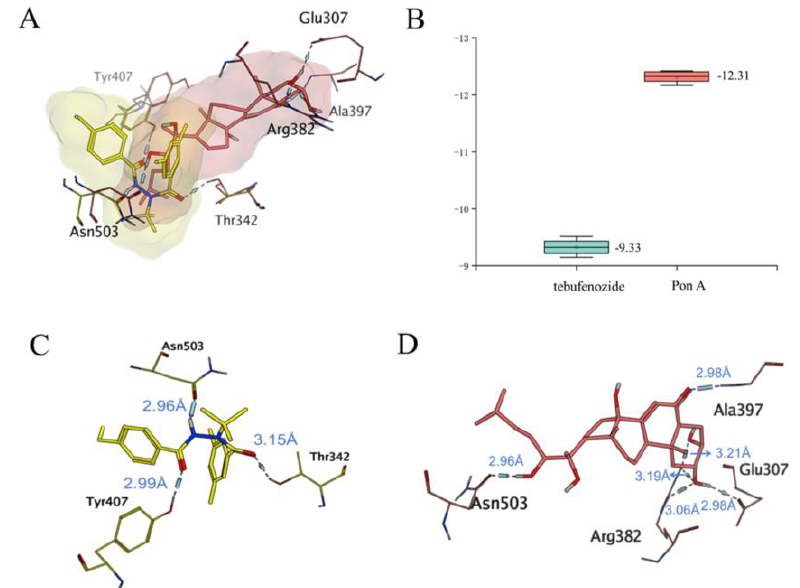
Figure 4. ( A ) Overlay diagram of the binding mechanism of tebufenozide and PonA in Px EcR − LBD (yellow, tebufenozide; pink, PonA). ( B ) Box plot of tebufenozide Cluster 1 and PonA Cluster 2 docking scoring comparison (blue, tebufenozide; pink, PonA). ( C ) The binding mechanism of tebufenozide and Px EcR − LBD. ( D ) The binding mechanism of PonA with Px EcR − LBD.